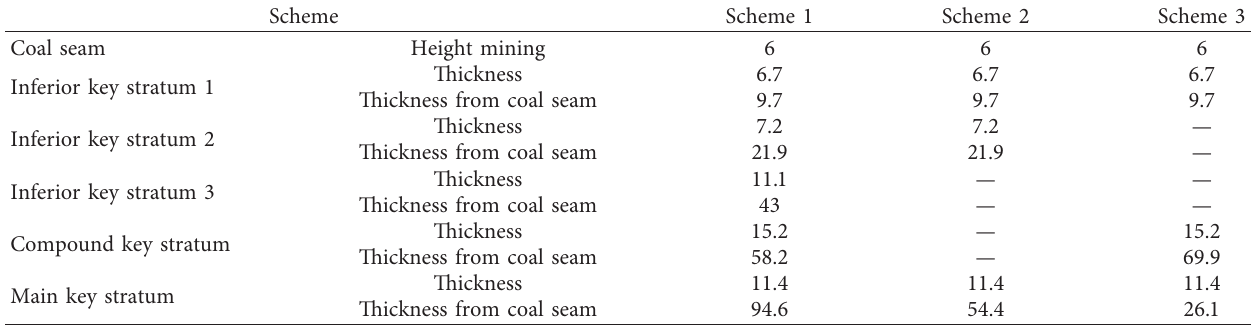
Table 5: The key stratum positions of each experimental